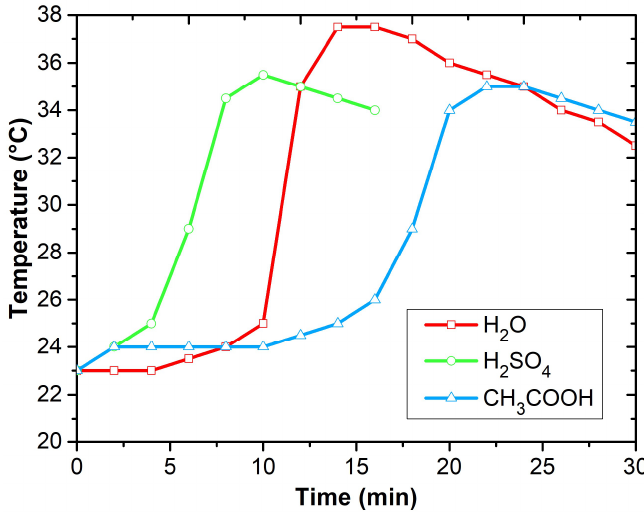
Figure 4. The temperature of the reaction mixture as a function of time.